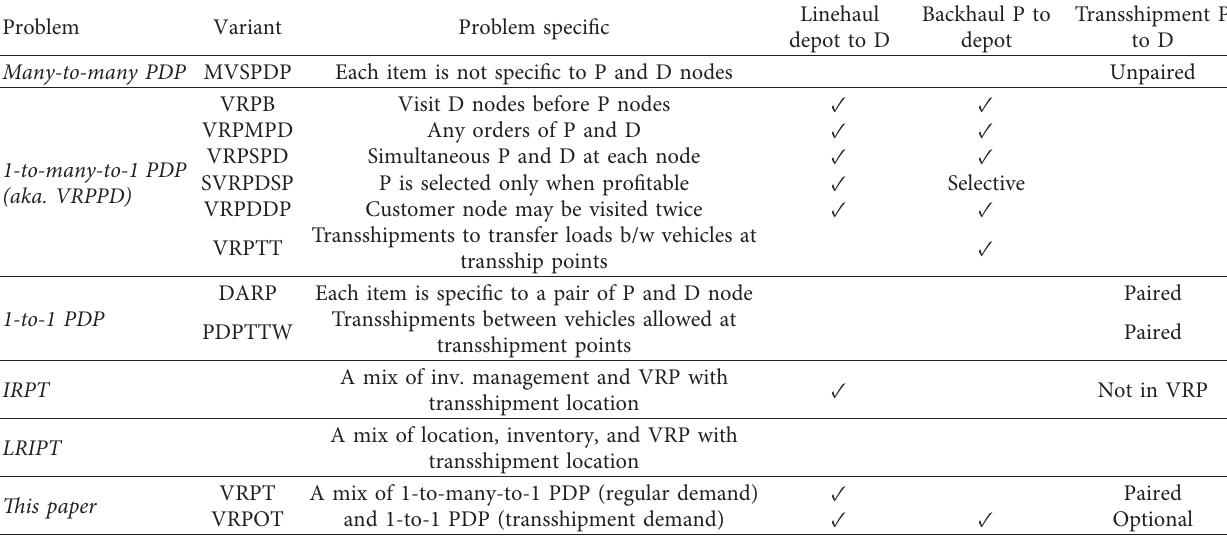
Table 1: Research